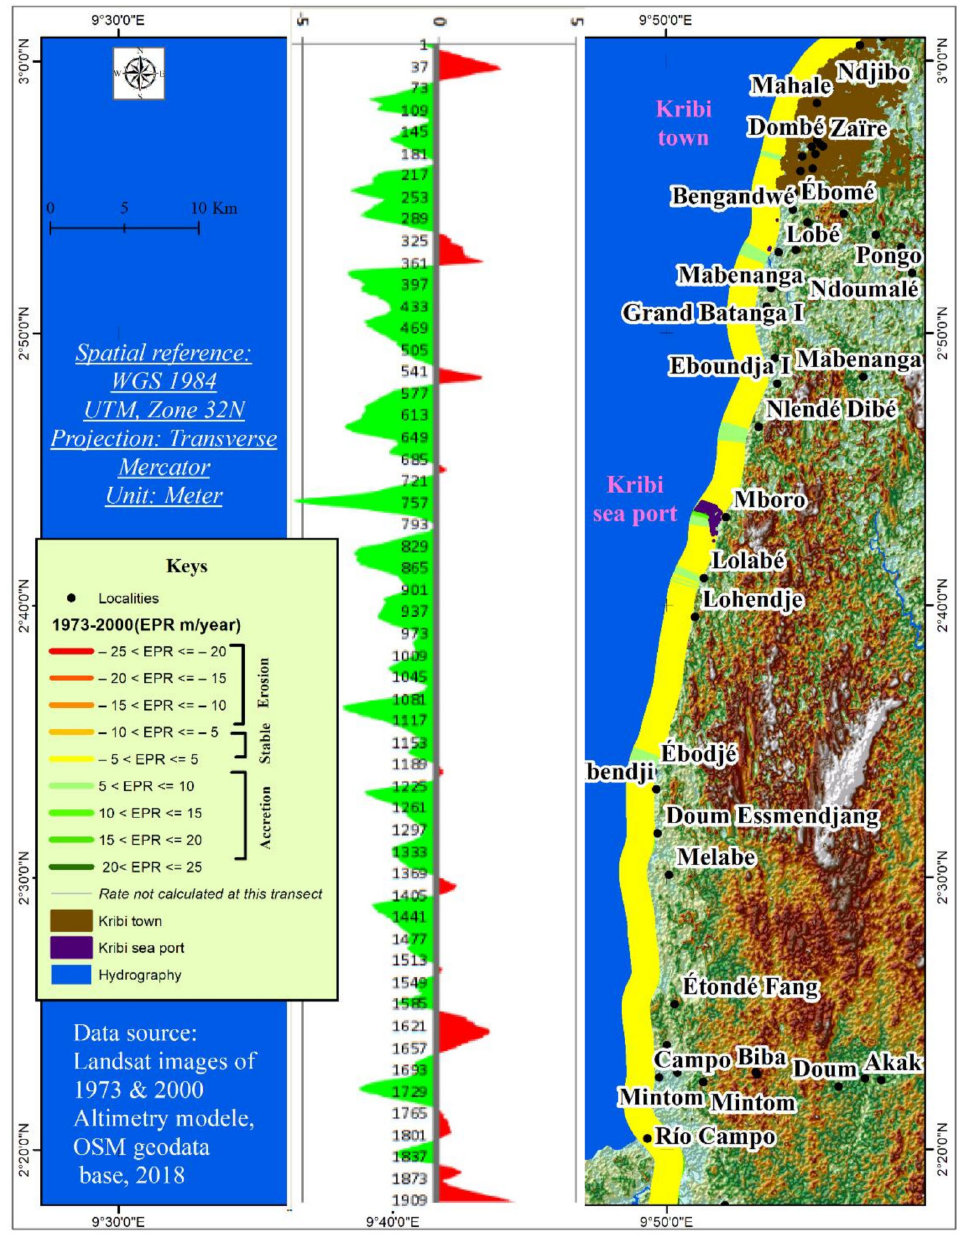
Figure 14. Rate of change (meters per year) in Kribi coastal erosion between 1973–2000. The figure was obtained with DSAS, from the linear extracted from Landsat images. The coastlines are divided into 1909 transects separated by 50 m. The cartographic representation is on the left. The graphic representation is on the right, with the number of transects on the ordinate axis, and the EPR in m/year on the abscissa